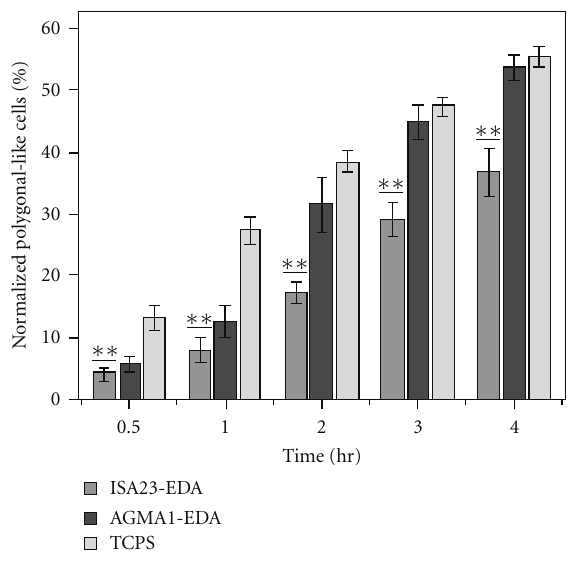
Figure 5: MDCK cells adhesion versus time on ISA23-EDA, AGMA1-EDA, and TCPS